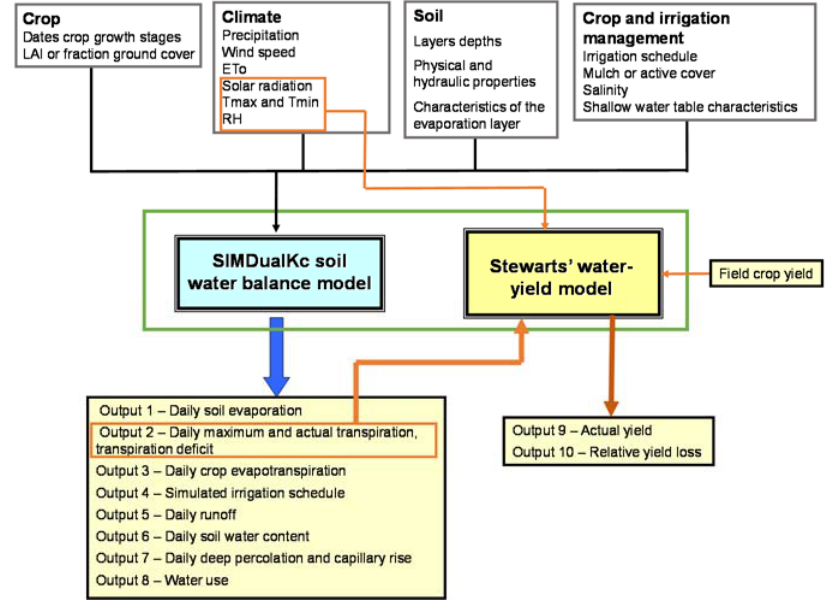
Figure 2. Flow-chart for the simplified approach combining the soil water balance model SIMDualKc with the Stewart’s water–yield model.